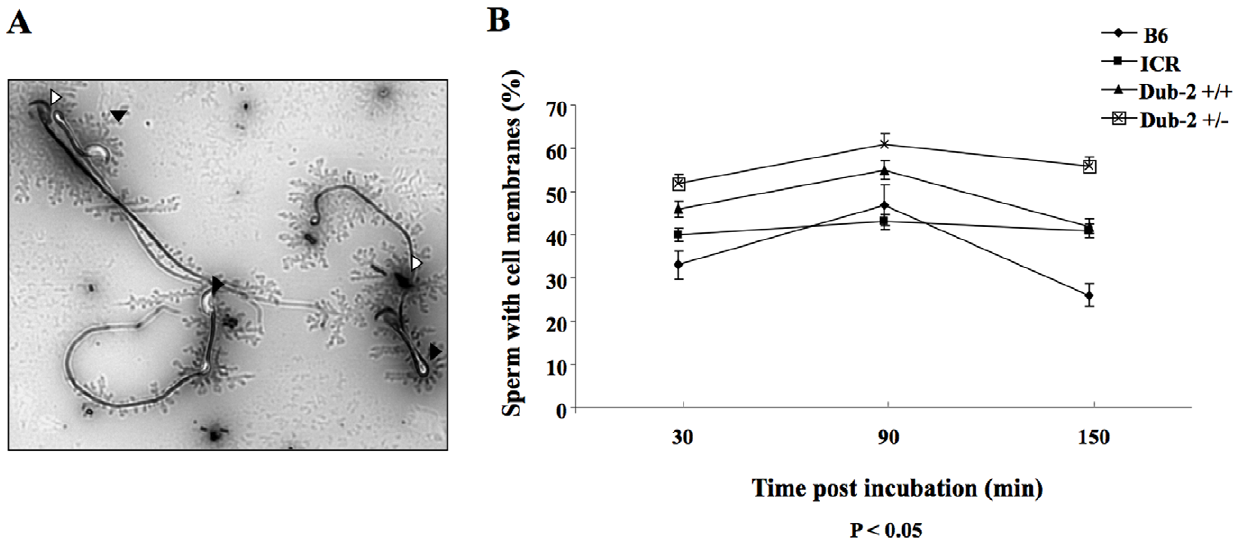
Figure 5. Analysis of sperm survival. A) Vital staining of sperms. White arrows indicate dead sperms and black arrows indicate survival sperms. B) Percentages of mouse sperm with intact cell membranes for B6 mouse, ICR, 129SV, Dub-2 + / + , and Dub-2 + / 2 . Dub-2 + / 2 group appeared to have lower sperm survival as identified by the vital staining after time post incubation. doi:10.1371/journal.pone.0044223.g005 PLOS ONE |